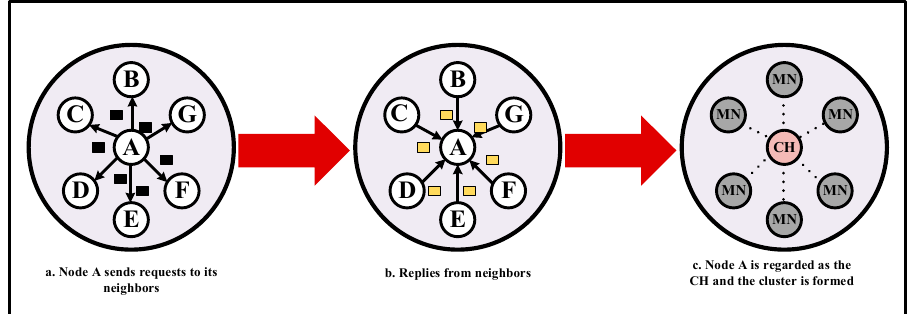
Figure 5. The process of clusters establishment.